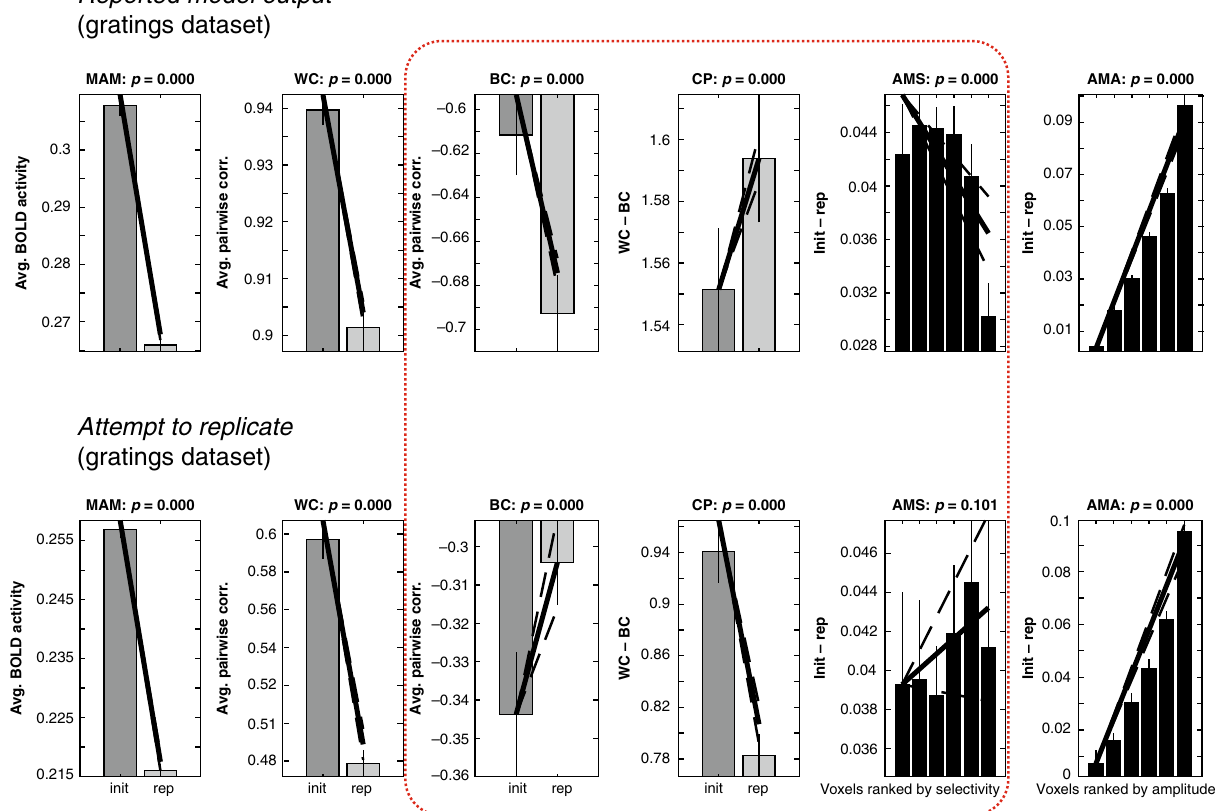
Fig. 1 Noise parameters in fl uence feed-forward models of fMRI-pattern correlations. Top row: pattern of results reported by Alink et al. for the winning parameter combination [ a = 0.8, b = 0.4, σ = 0.4] for the grating dataset (cf. Supplementary Fig. 4 in Alink et al.). The direction (increase or decrease when comparing initial and repeated responses) of the six empirically observed data-features (cf. Figure 3 in Alink et al.) is only observed when uniformly distributed noise in the interval [0, 0.1] is added to the simulated brain patterns. Bottom row: the qualitative pattern of results observed for the winning parameter combination shown in the top row changed substantially when adding zero-mean Gaussian noise with a standard deviation of 0.1 instead of uniformly distributed noise. Of particular interest, the data-features BC, CP, and AMS are (shown within a red box) no longer qualitatively consistent with the empirical observations. Compare the corresponding slopes of lines in the top and bottom rows. Init initial presentation, rep repeated presentation, MAM mean amplitude modulation, WC within-class correlation, BC between-class correlation, CP “ classi fi cation performance ” (CP = WC − BC), AMS amplitude modulation by selectivity, AMA amplitude modulation by amplitude. Solid bars indicate mean of each condition and error bars 95% con fi dence intervals given the (simulated) between-participant variability. Diagonal lines indicate the slope of linear contrasts across conditions, and dashed lines indicate 95% con fi dence interval of the slope. See Alink et al. for methodological details and proposed interpretation of error bars and p values above each subpanel. In our view, given that arbitrary modeling choices determine the across-subject variability produced by the model, the reported error bars and accompanying p values have therefore little, if any, statistical